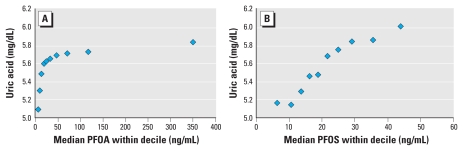
Observed uric acid with increasing PFOA (A) and PFOS (B) unadjusted for covariates.